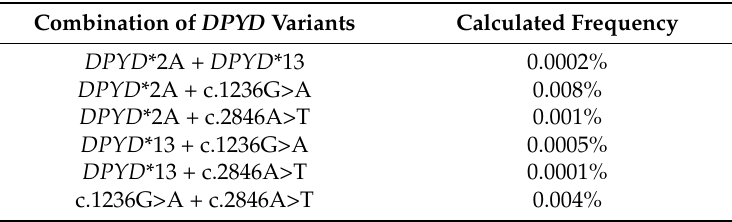
Table 5. Calculated frequencies for compound heterozygous DPYD patients. Using the average MAFs of the ExAC and gnomAD databases (for DPYD *2A, DPYD *13, c.1236G>A, and c.2846A>T, these are 0.55%, 0.03%, 1.43%, and 0.27%, respectively), possible combinations for two out of four currently genotyped DPYD variants are shown. Abbreviations: MAF: minor allele frequency; ExAC: Exome Aggregation Consortium; gnomAD: Genome Aggregation